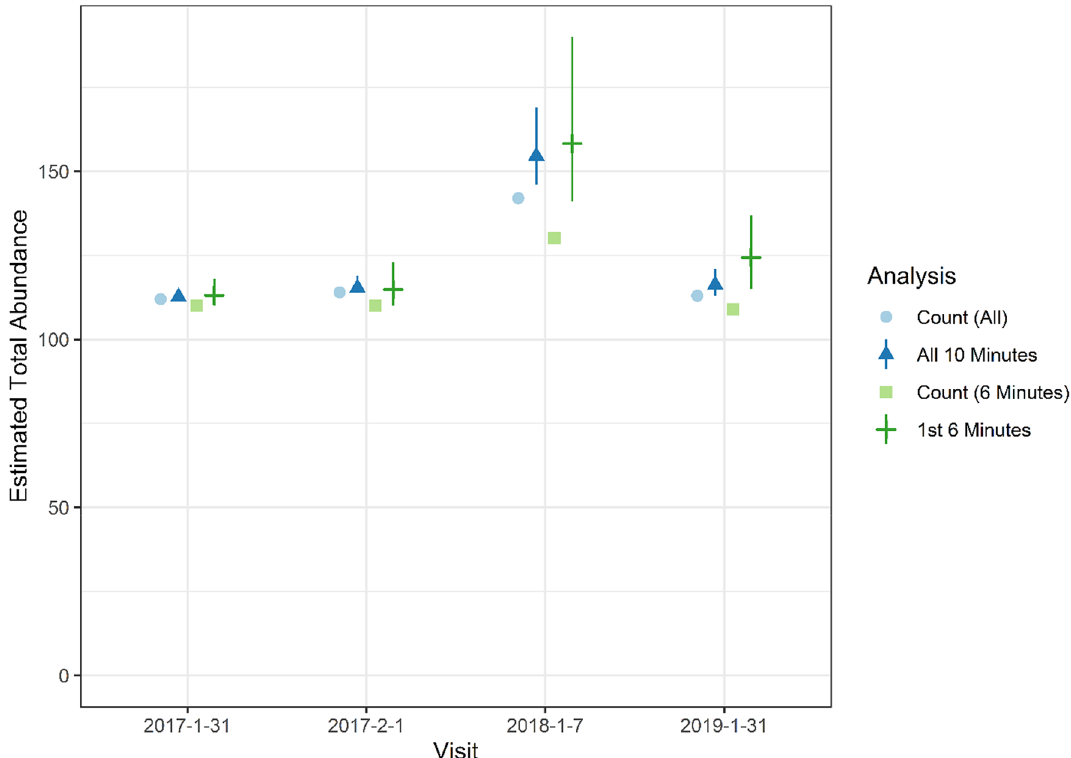
Figure 8. Total count (circles and squares) and abundance estimates (triangles and crosses) by visit, excluding Big Cypress. Symbols indicate means (point estimates) and lines 95% credible